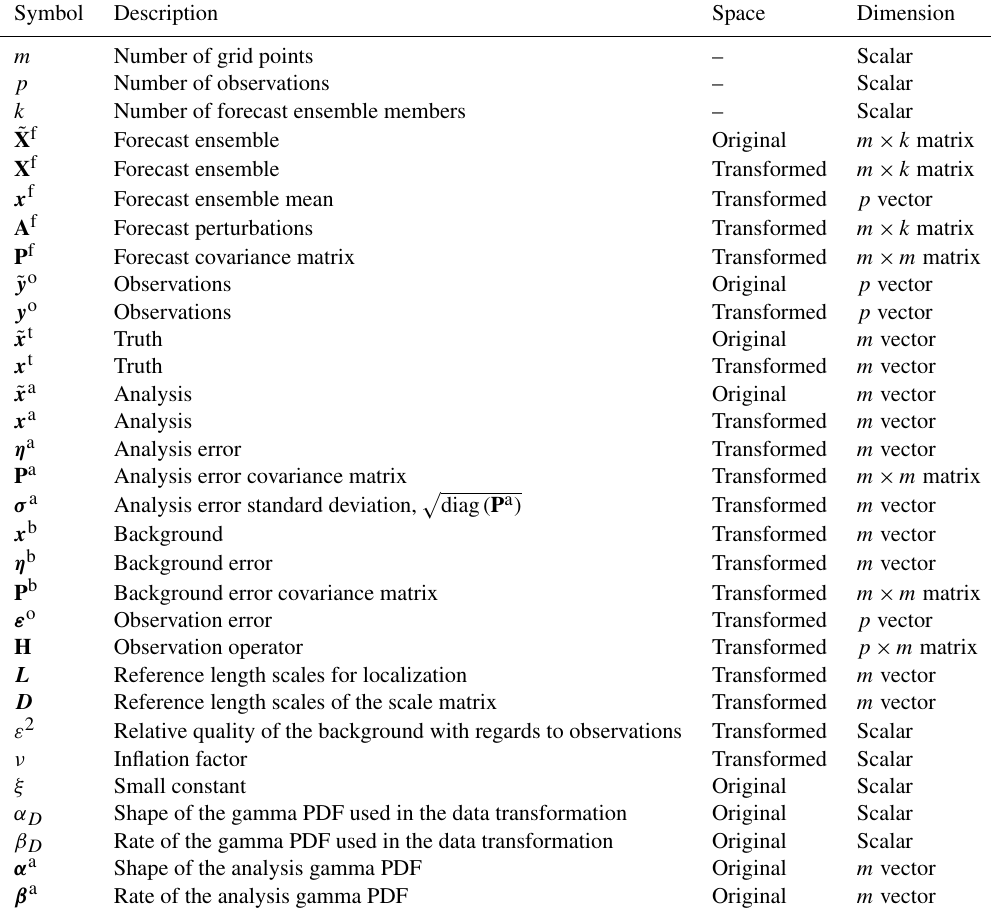
Table 1. Overview of variables and notation for global variables. All the vectors are column vectors unless otherwise specified. If X is a matrix, X i is its i th column (column vector), and X i, : is its i th row (row vector). Note: PDF – probability density